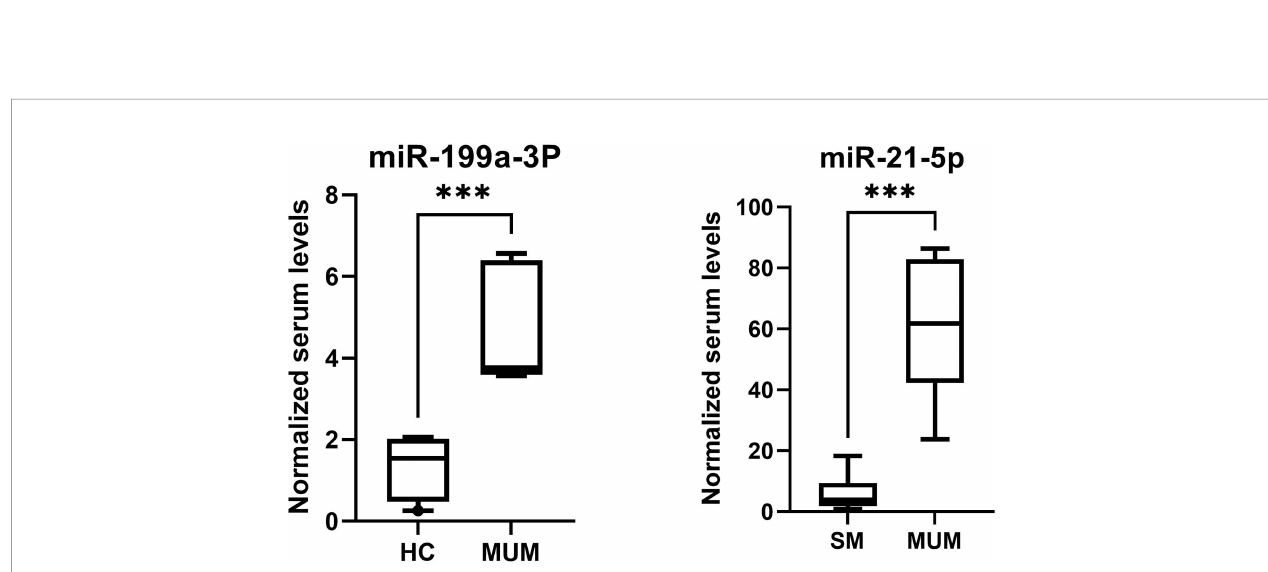
FIGURE 7 | Results of ROC analysis of miR-214-3p, miR-21-5p, and miR-132-3p between spindle melanoma and epithelioid cell melanoma.